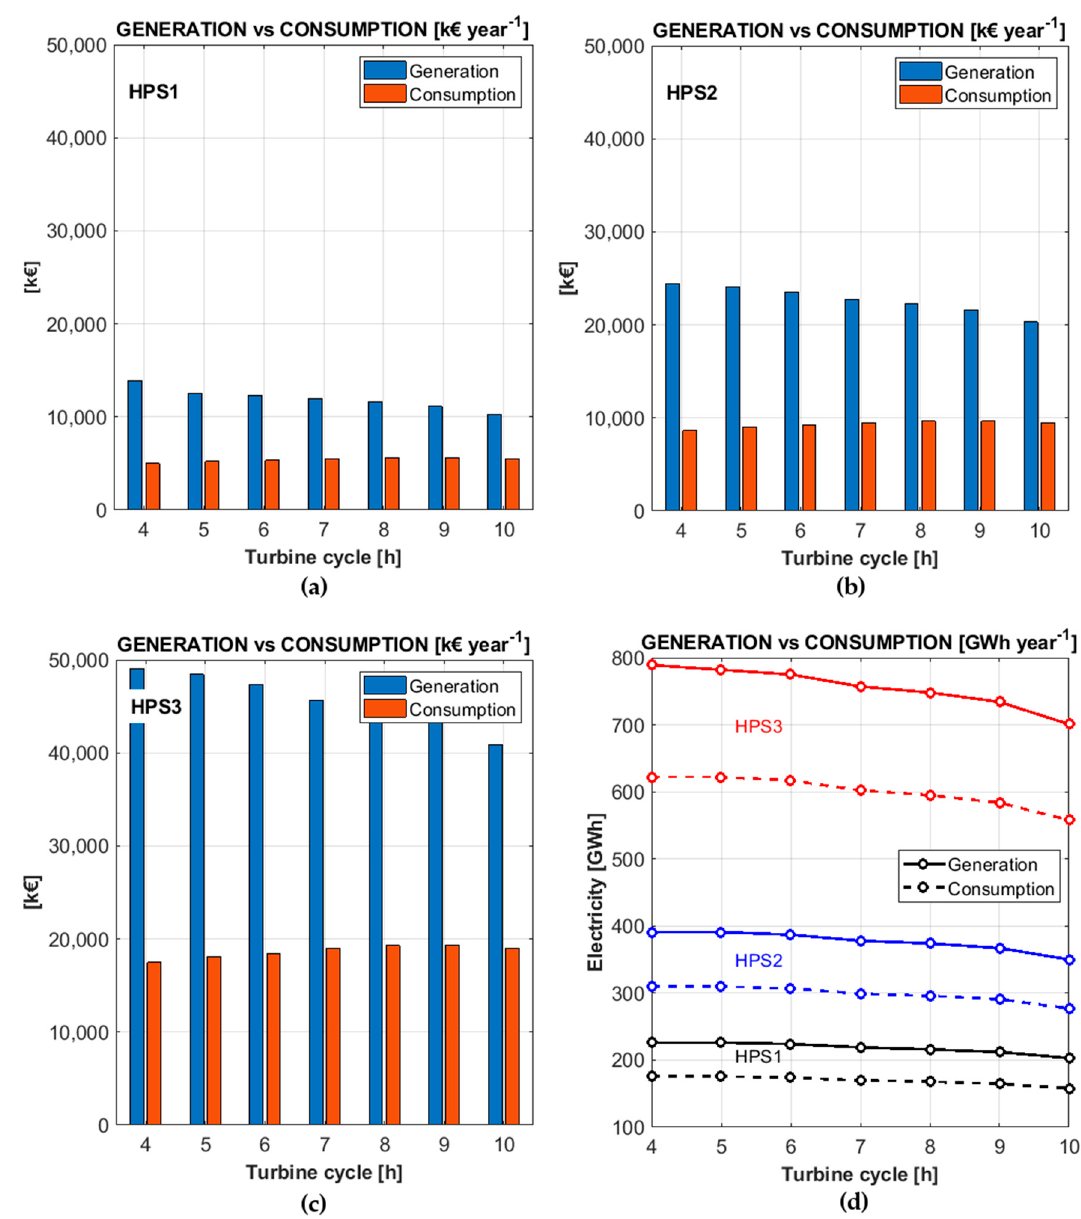
Figure 5. Maximum income from selling energy and minimum cost for purchasing energy, considering DTCs between 4 and 10 h: ( a ) HPS 1; ( b ) HPS 2; ( c ) HPS 3. ( d ) Amount of energy generated and consumed for HPS 1, HPS 2 and HPS 3.